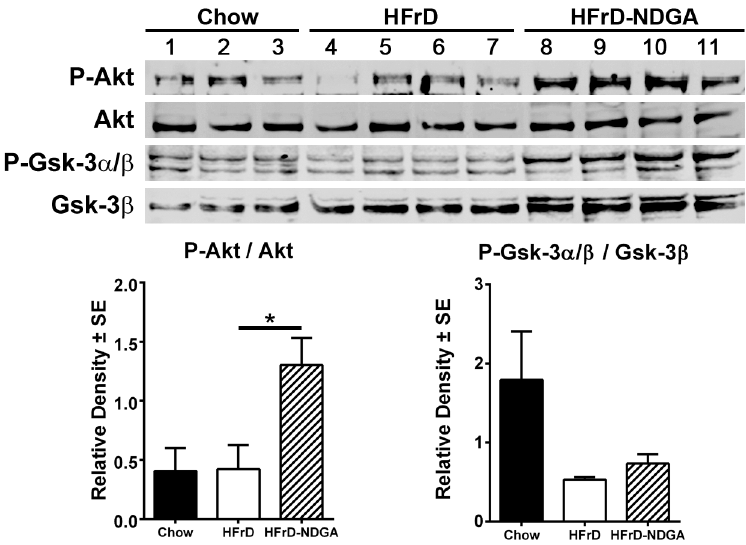
Fig 7. Effect of NDGA treatment by oral gavage on expression and phosphorylation of Akt and GSK3 β . After 8 weeks of Chow, HFrD feeding or HFrD feeding-NDGA treatment, animals were fasted for 4h before tissue collection and liver homogenates were immunoblotted for P-Akt, total Akt, P-GSK α / β , and total GSK3 β . Representative blots for these proteins are shown. Data presented are means ± SE of 3 – 4 individual samples. * P < 0.05; ** P < 0 . 01; *** P < 0 . 001 . Raw data and statistics are listed in S1